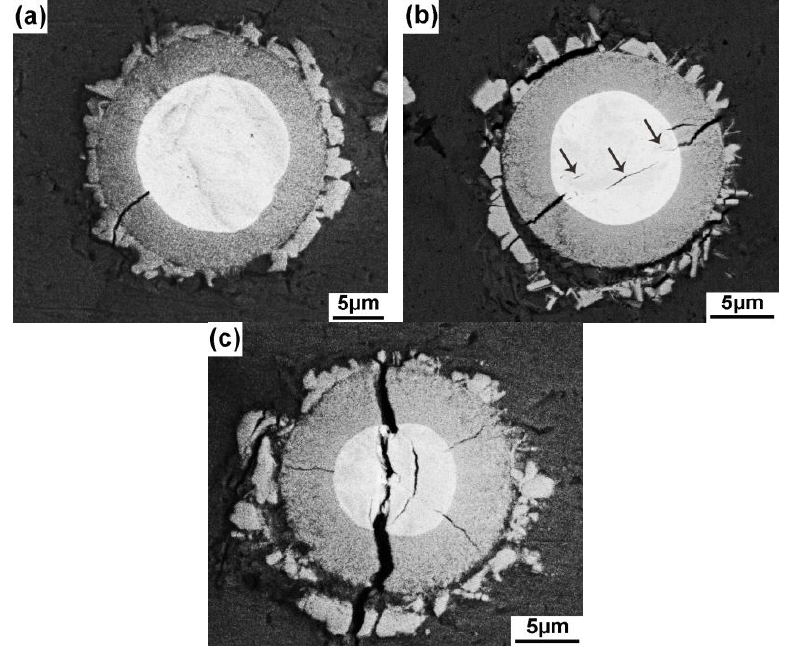
Figure 16. SEM micrographs of core-shell-structured reinforcements in the composite thixoformed at 200 °C showing the fracture process during in situ tensile testing.